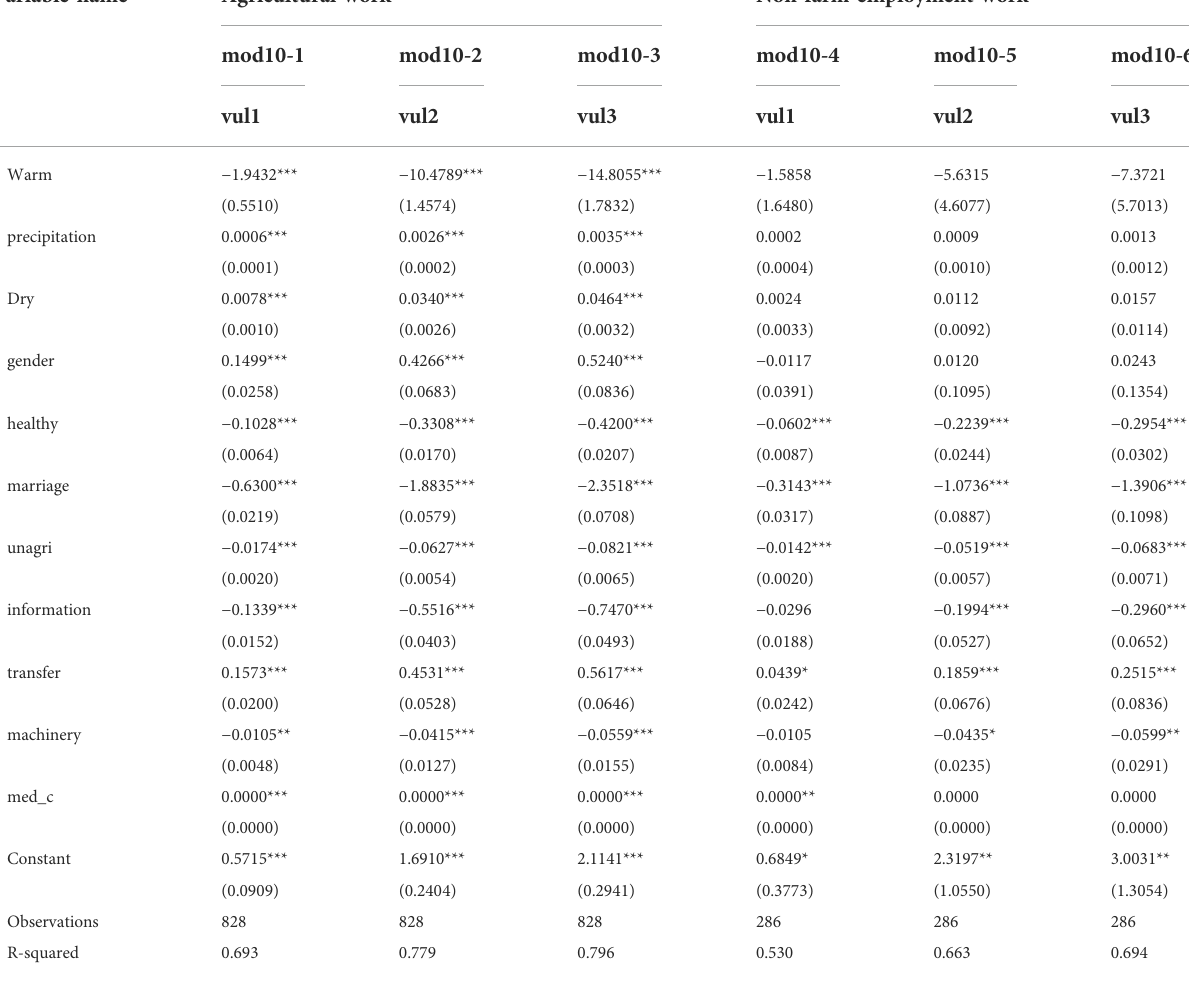
TABLE 10 Sub-sample regression results of the impact of extreme weather on poverty vulnerability of farm households (agricultural work vs non- farm employment